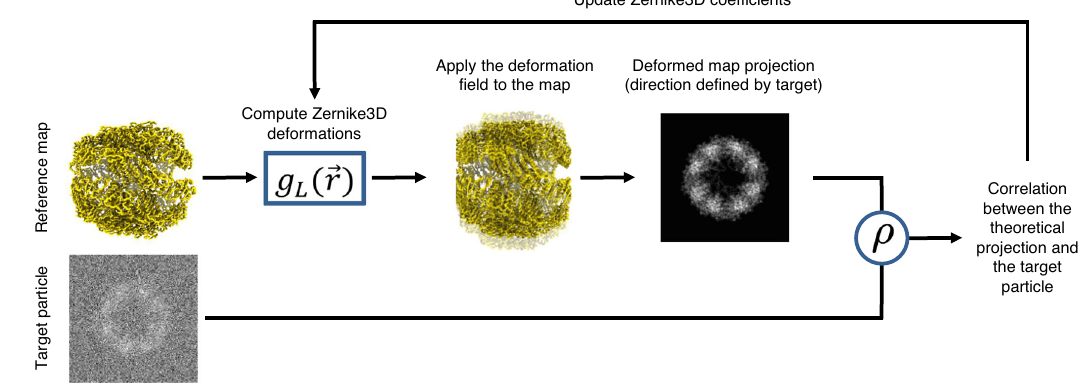
estimated by Powell ’ s conjugate direction method, so Pearson ’ s correlation coef- fi cient ρ between the experimental and theoretical projection obtained from the deformed map is